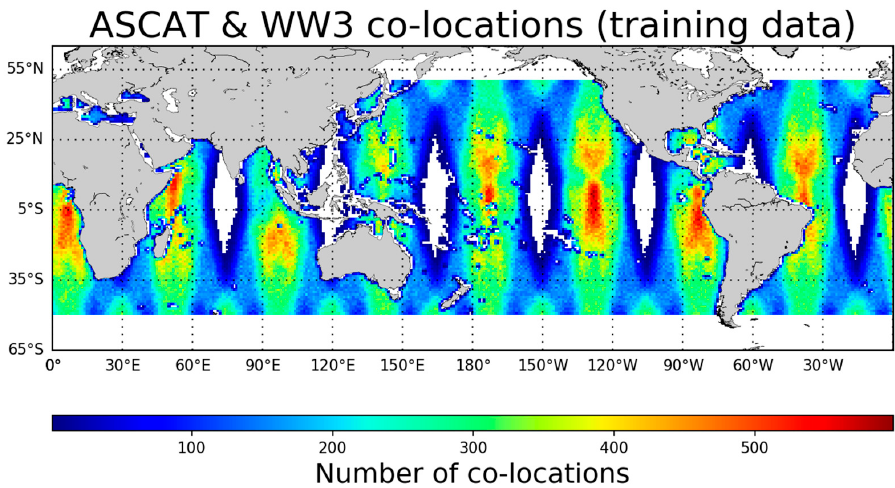
Figure 1. Number of Advanced Scatterometer (ASCAT)-WW3 matchups (training dataset) on 1° × 1° grid.